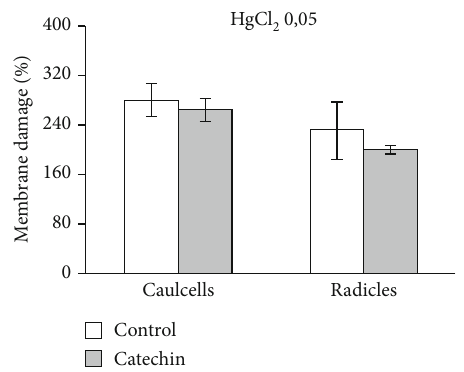
Figure 3: Membrane damage in Lactuca sativa caused by 0.05 mM HgCl in the absence and presence of catechin. 2